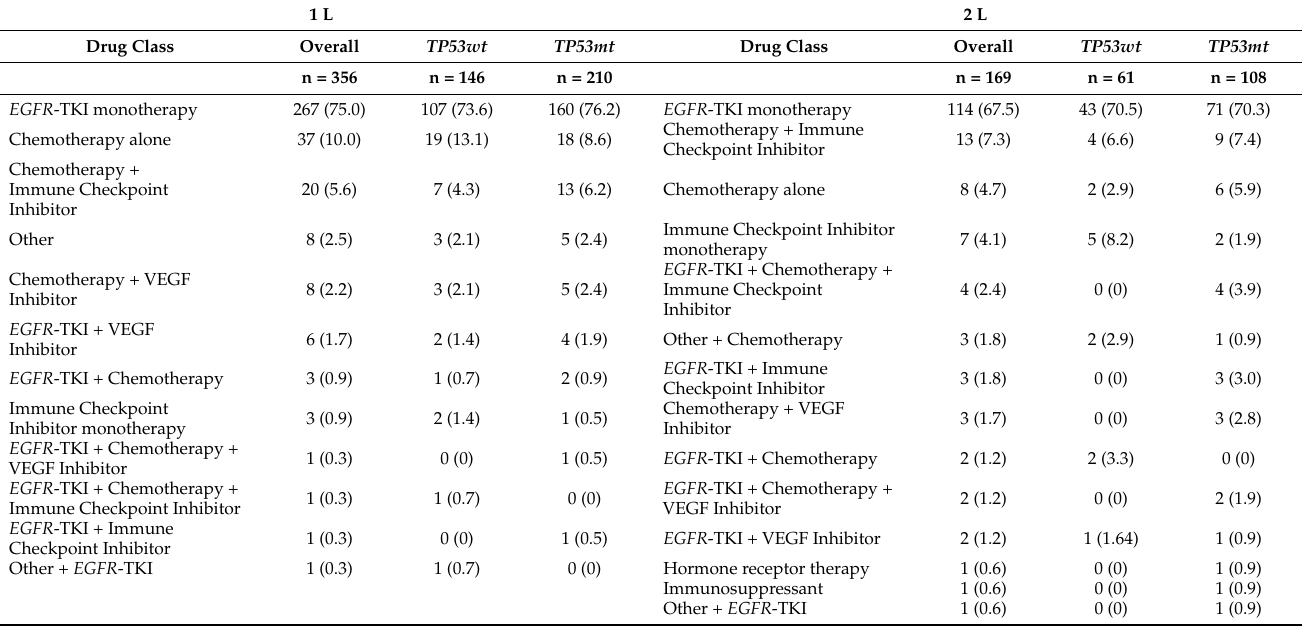
Table 2. Treatment patterns in 1 L and 2 L—by drug